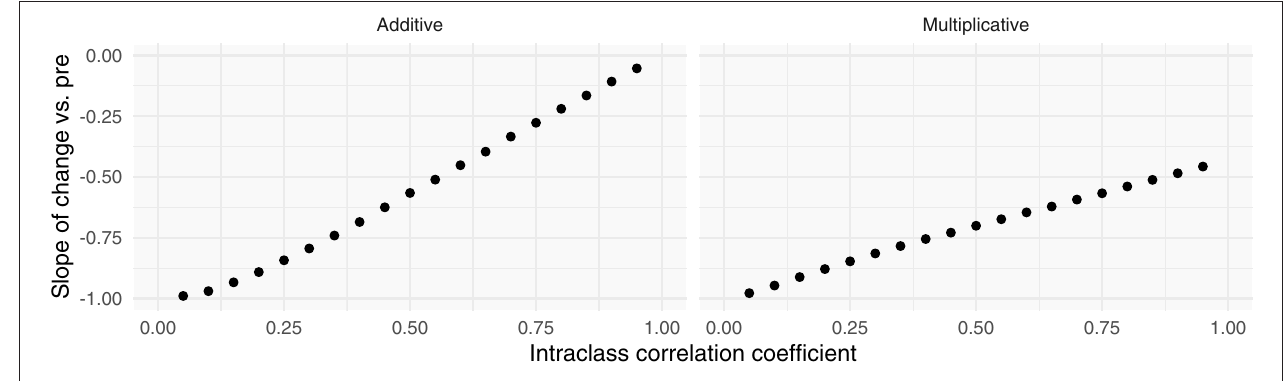
FIGURE 3 | Simulations of additive and multiplicative changes reveal the effect of different intraclass correlation coefficients on the slope between change scores and pre-intervention scores. Additive effects have slopes that trend toward zero with increasing ICC’s, while multiplicative effects always have a negative slope no matter their